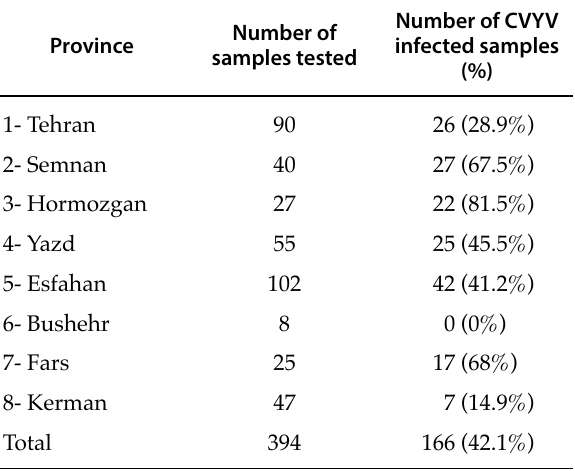
Table 1 . Number of greenhouse grown cucumber samples that were tested positive by ELISA for the presence of Cu- cumber vein yellowing virus (CVYV) from a survey under- taken in eight provinces of Iran during